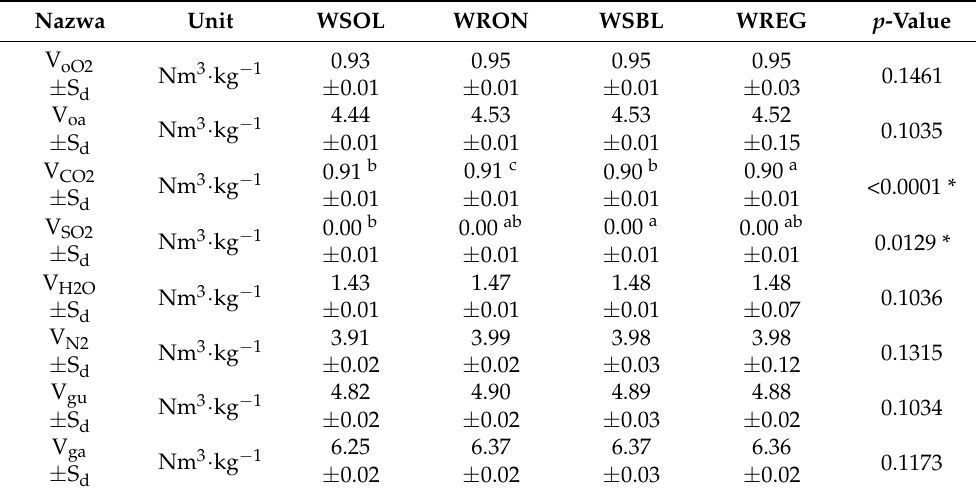
Table 7. The balance of the amount of substances in the process of burning vine shoots. Nazwa